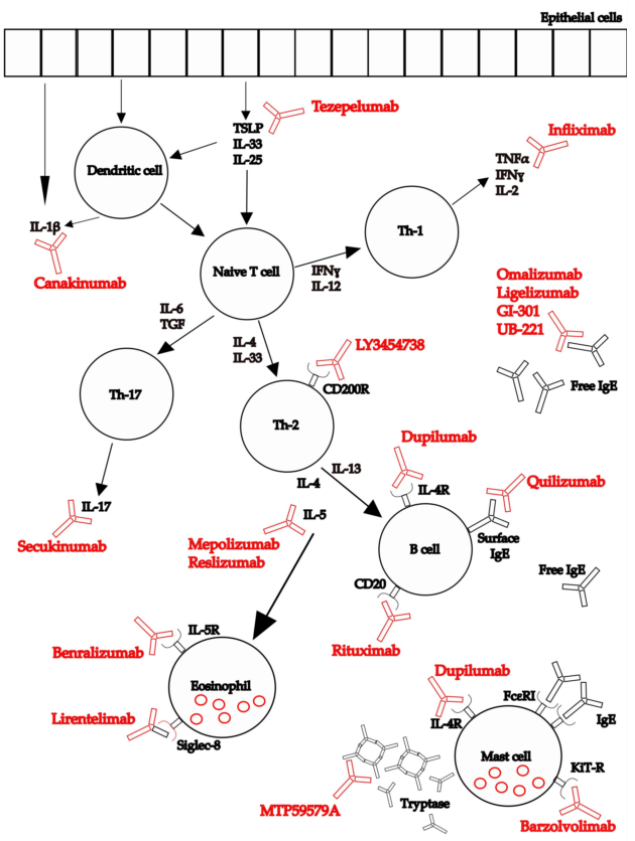
Figure 1. Biologics for chronic spontaneous urticaria (CSU). Biologics and their target structures, receptors and mediators tested for treating CSU.